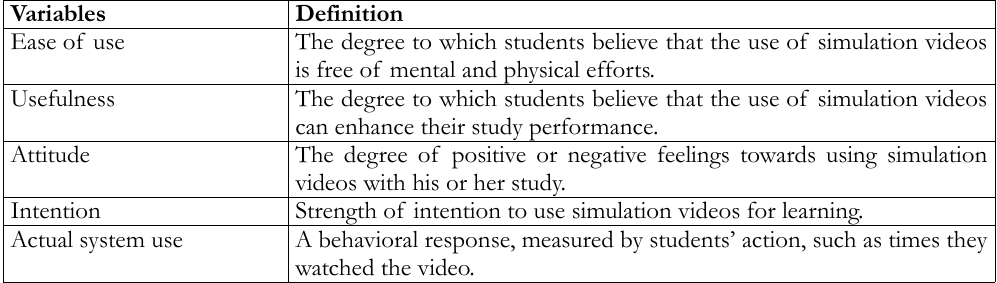
Table 2. TAM Variables (Adapted from Chen et al.,